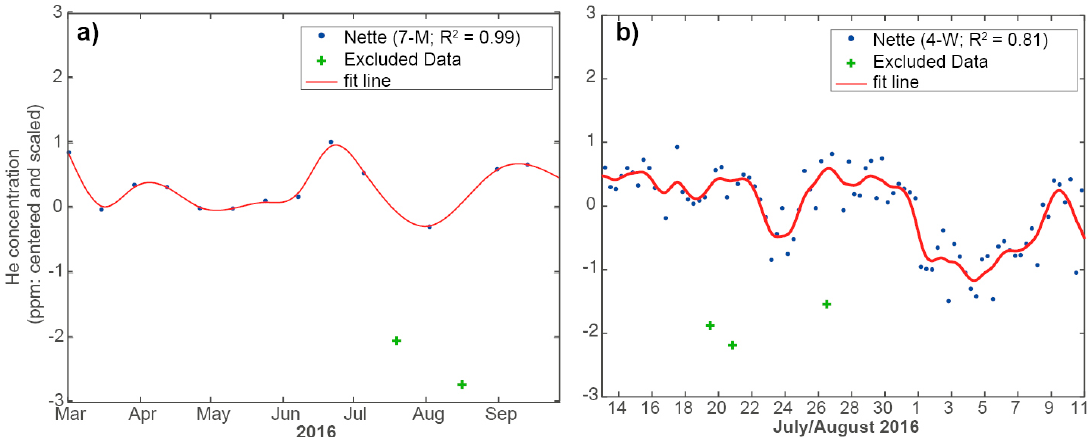
Figure 2. Fluctuation patterns of helium concentrations before (blue dots) and after centering/scaling and applying the smoothing spline method (red line) for the Nette mineral spring for ( a ) the 7-month biweekly and ( b ) the 4-week 8-hourly measurement campaigns. Measured data > 1.5 standard deviations from centered and scaled data were excluded from analysis (green crosses) for being outliers.